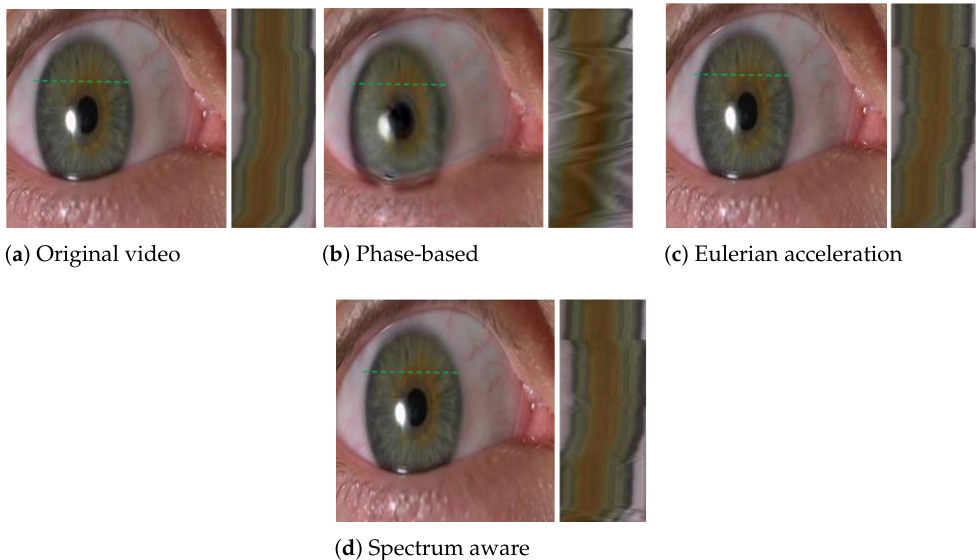
Figure 7. The eye video and its magnification with the phase-based approach, the Eulerian-acceleration approach, and our spectrum-aware processing. The spatio-temporal slice is shown in each approach for the green stripe (top-left). This video demonstrates an eye moving along the horizontal direction, as shown in the original sequence; such wobbling is too subtle to be observed (top-left). The global motion of the eye generates significant blurring artifacts when processed with the phase-based approach. However, processing the sequence with Eulerian acceleration and our approach show clearly that the iris wobbles as the eye moves; through the in-depth comparison, more local details can be preserved in our approach